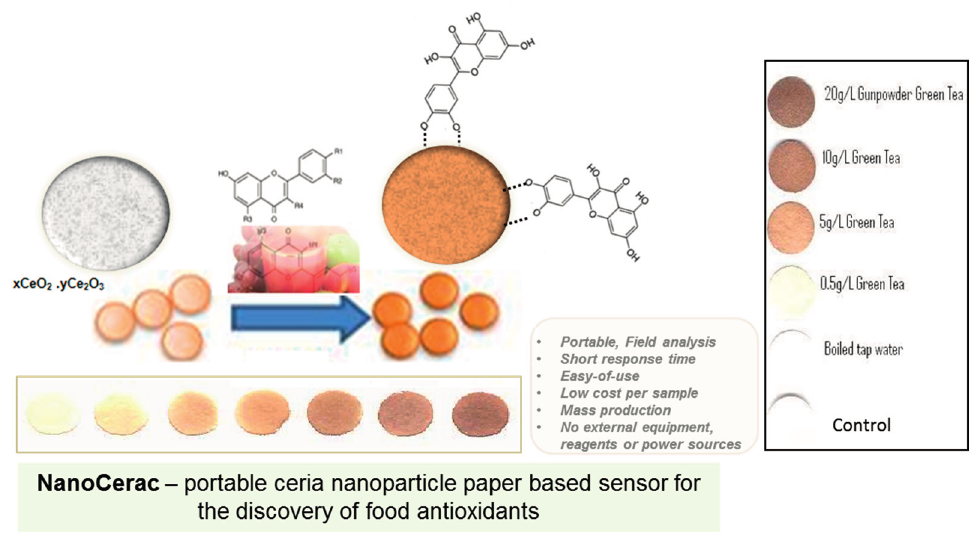
Figure 4. Operational concept of the NanoCerac assay based on surface-immobilized nanoceria particles for field analysis of antioxidants (reproduced from [55] with permission of The Royal Society of